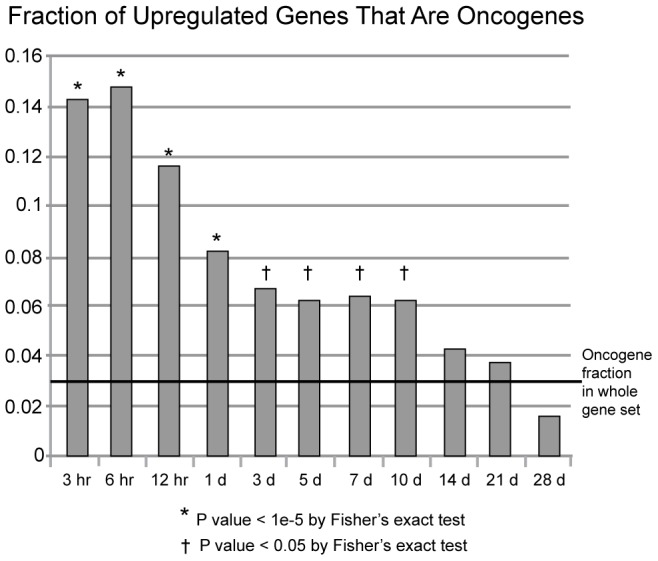
Enrichment of oncogenes during the early time points.All upregulated DE genes at each time point (when compared to the zero hour control) were interrogated for being oncogenes by their presence in the Memorial Sloan Kettering Cancer Center Oncogene set (http://cbio.mskcc.org/CancerGenes/Select.action) and then performing a Fisher's exact test to assess significance. The enrichment of oncogenes during the first day is highly statistically significant (P-value<10−5). Late in the time course, oncogenes are not significantly enriched in the upregulated DE gene sets.